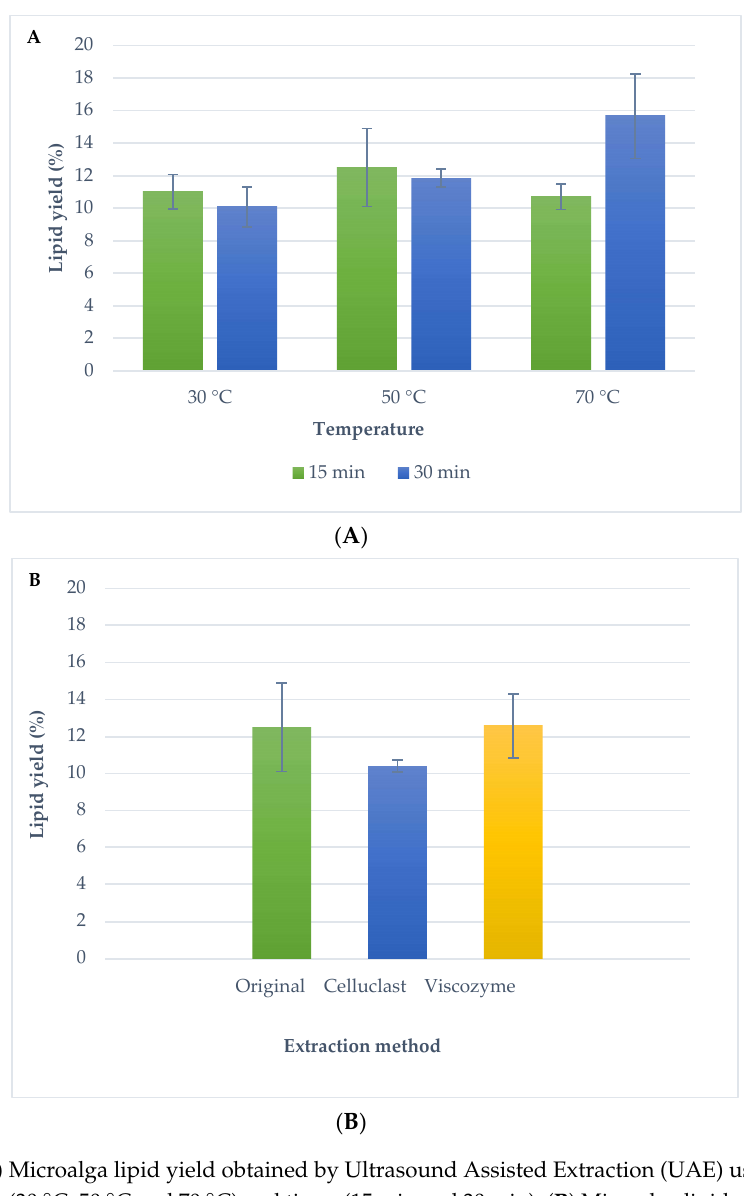
Figure 1. ( A ) Microalga lipid yield obtained by Ultrasound Assisted Extraction (UAE) using different temperatures (30 °C, 50 °C and 70 °C) and times (15 min and 30 min); ( B ) Microalga lipid yield obtained by UAE (50 °C 15 min) using different enzymatic pre-treatment (Celluclast and Viscozyme). Error bars denote the standard deviation of two independent determinations.